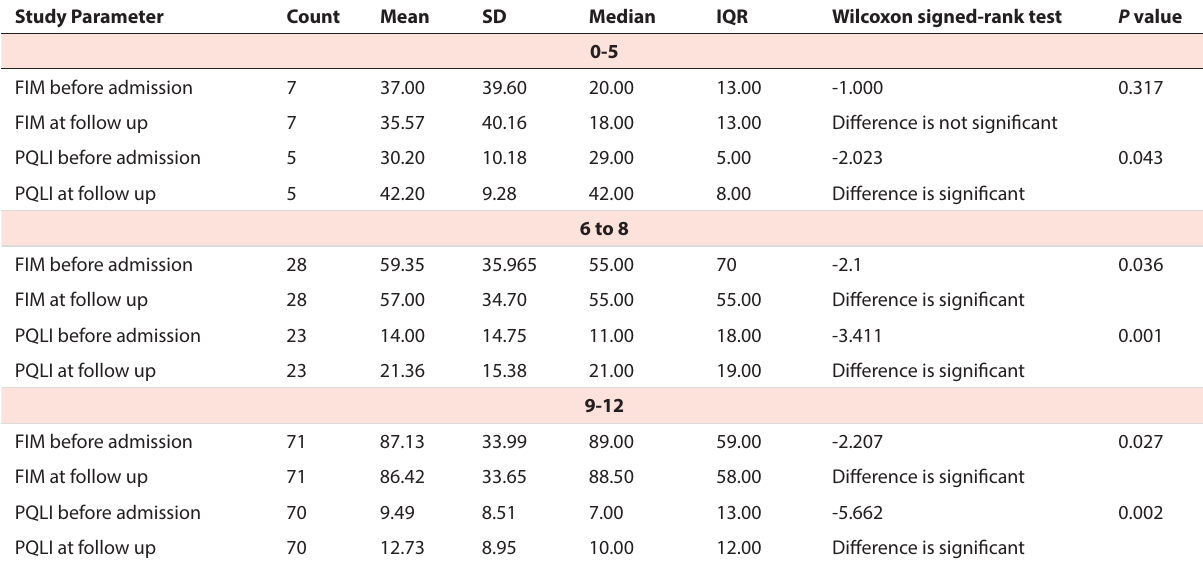
Table 4. Comparison of FIM and PQLI before admission and during follow up at one month with PTS Study